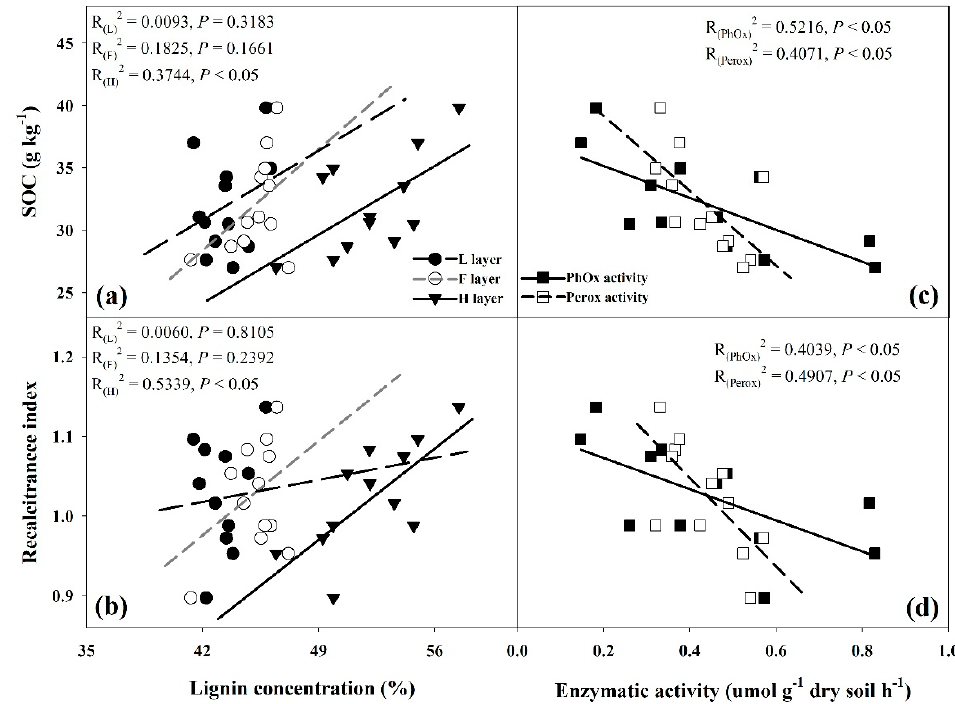
Figure 1. Relationships between lignin concentration and soil organic carbon content ( a , SOC), recalcitrance index ( b , (Alkyl C + Aromatic C)/( O -alkyl C + Carbonyl C) ratio) in the L (litter), F (fermentation), and H (humified) layers. Relationships between ligninolytic enzyme activities and SOC content ( c ), and recalcitrance index ( d ). PhOx denotes phenol oxidase activity and Perox denotes peroxidase activity. Table 2. Effects of simulated acid rain (SAR) treatment and litter residue decomposition layer on δ 13 C value, lignin fraction concentration, and proportion of lignin fraction C to the total C (Lignin C/Total C).